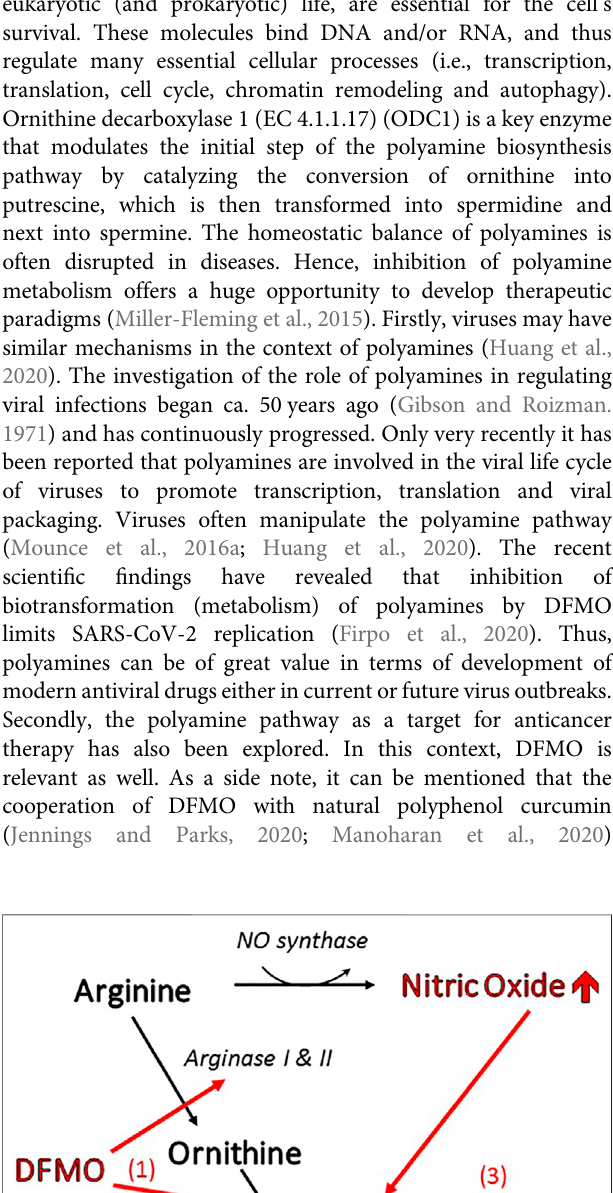
Frontiers in Chemistry |